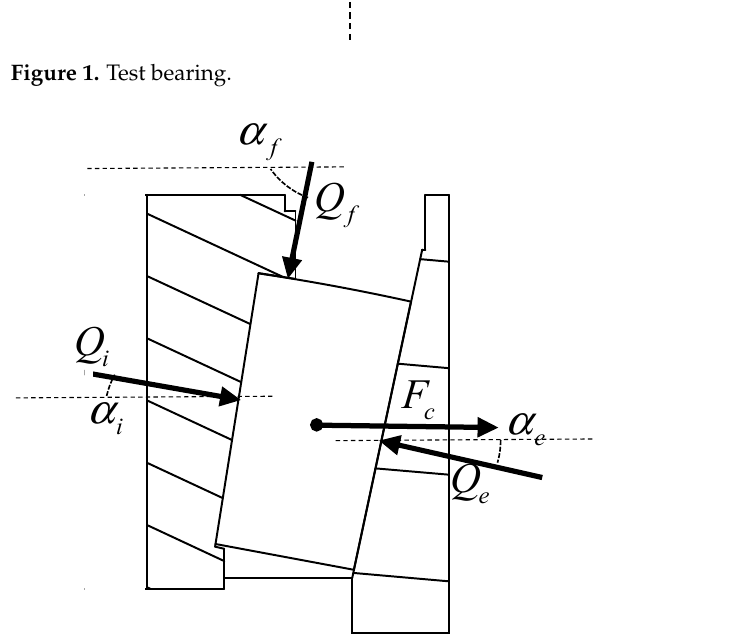
Figure 1. Test bearing.